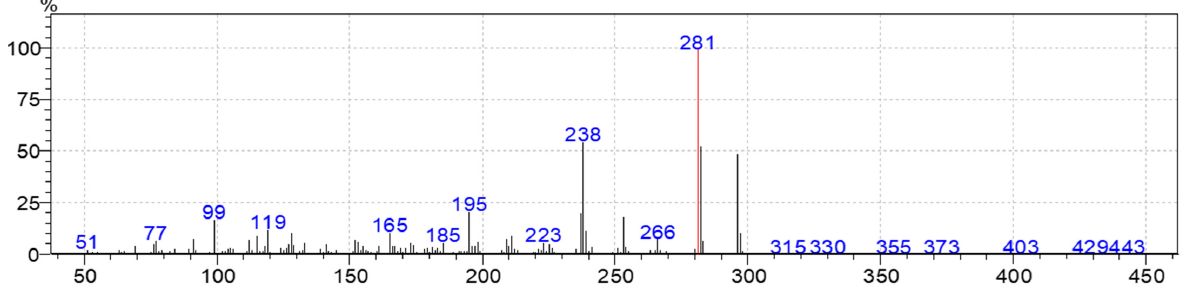
Figure 7. MS/MS chromatograms of Rutamarin in NVOs of T. ciliata.